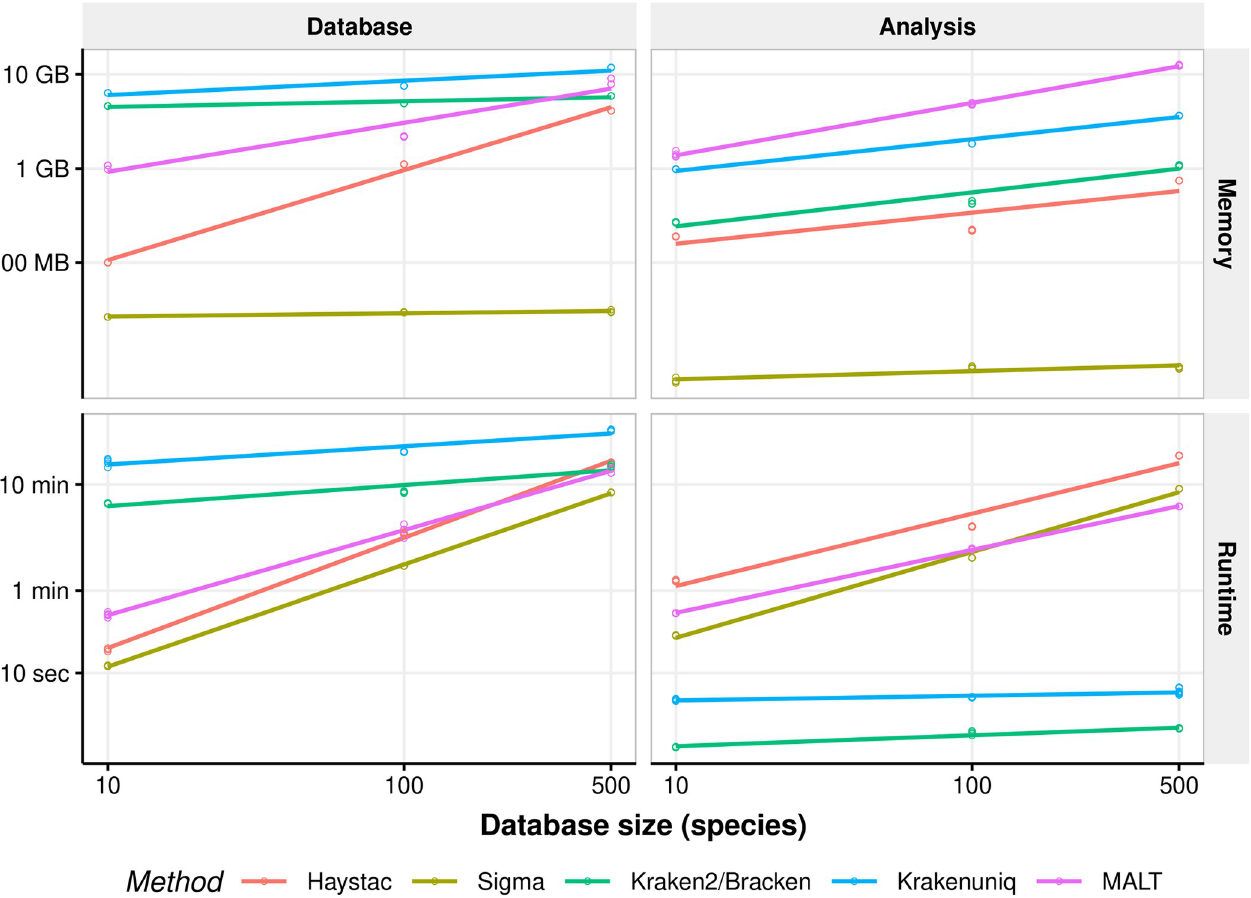
Fig 2. Computational performance of HAYSTAC and other methods. Linear regression of the elapsed time (wall clock) and peak memory usage (maximum resident set size) for a sample of size 1 million reads and reference databases containing either 10, 100 or 500 genomes, each with 5 replicates. When constructing the database, HAYSTAC uses substantially less memory and runs faster than either Kraken2/Bracken, KrakenUniq or MALT for restricted database sizes. When performing analyses, HAYSTAC uses less memory than Kraken2/Bracken, KrakenUniq or MALT, while its runtime was only marginally slower.